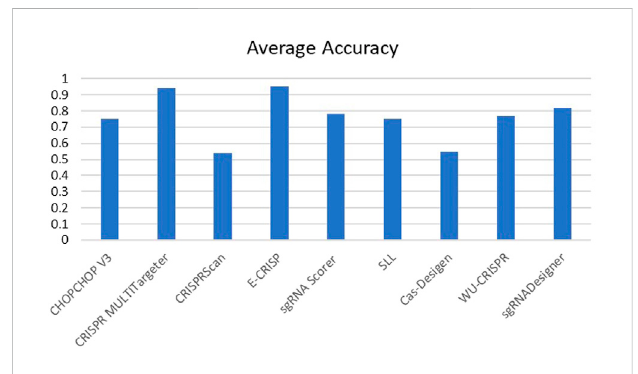
FIGURE 5 Average accuracy of off-target prediction.